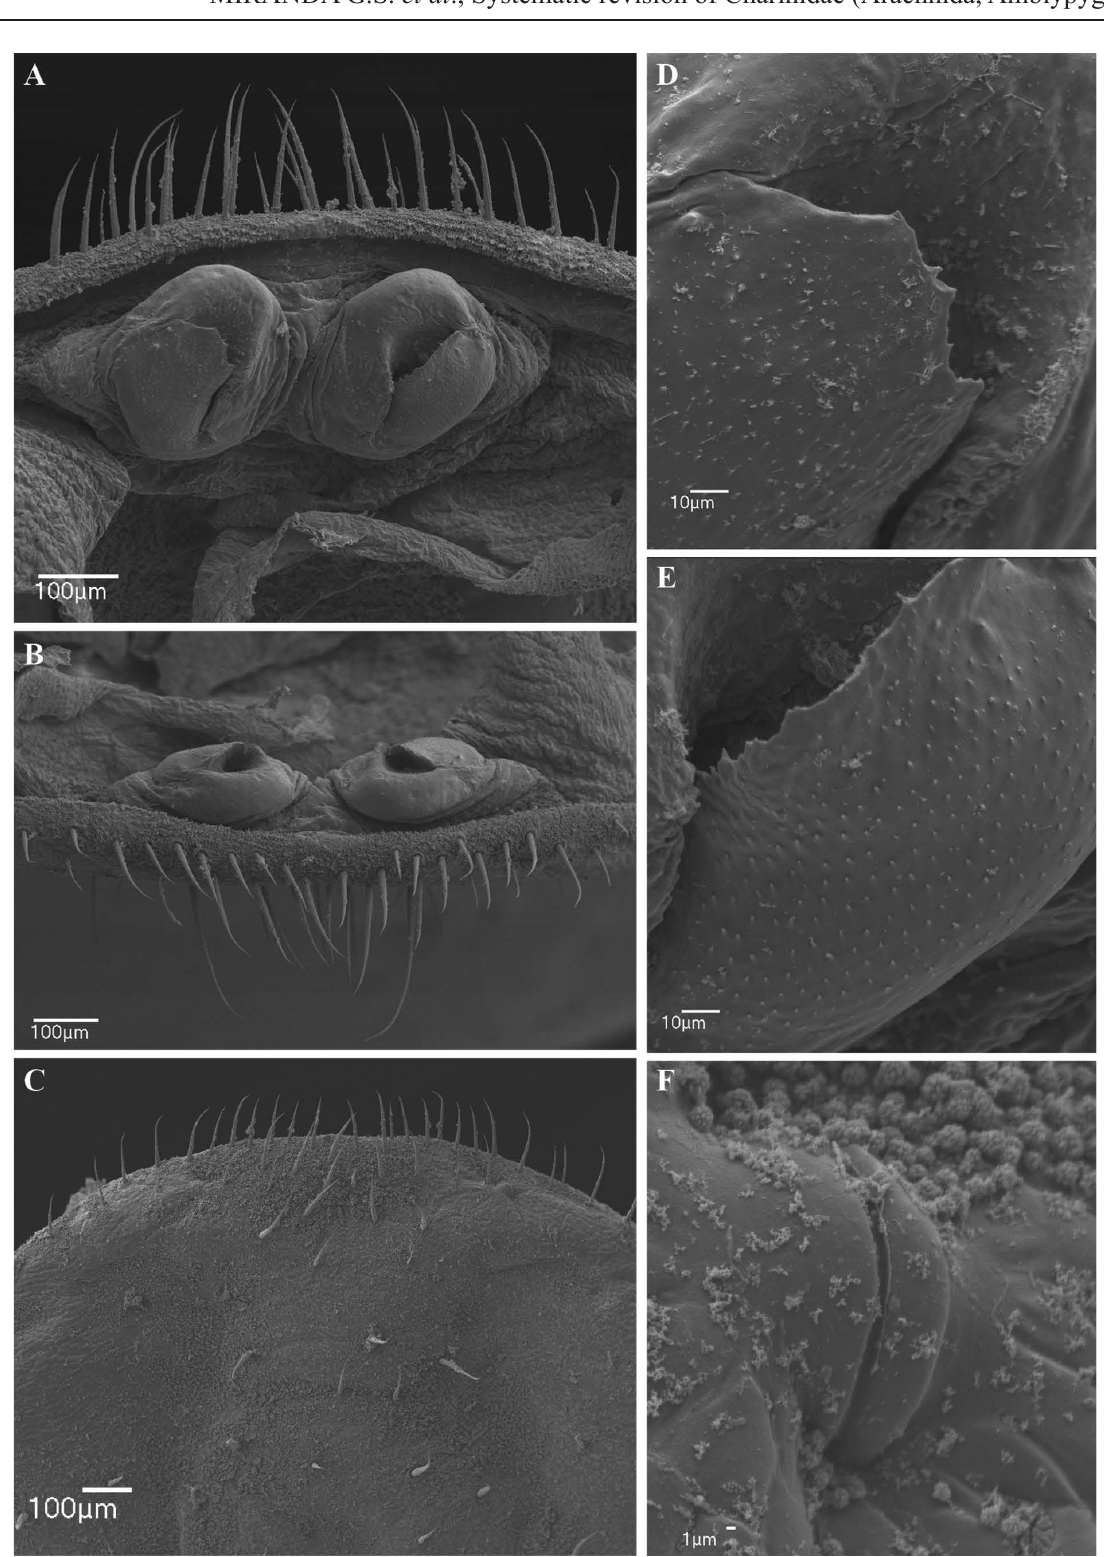
Fig. 91. Charinus loko sp. nov. (SMNS), female gonopod and genital operculum. A . Cushion-like gonopod, dorsal view. B . Gonopods, posterior view. C . Posterior margin of genital operculum, ventral view. D . Apex of projection on sinistral gonopod. E . Apex of projection on dextral gonopod. F . Glandular opening on margin of genital operculum,